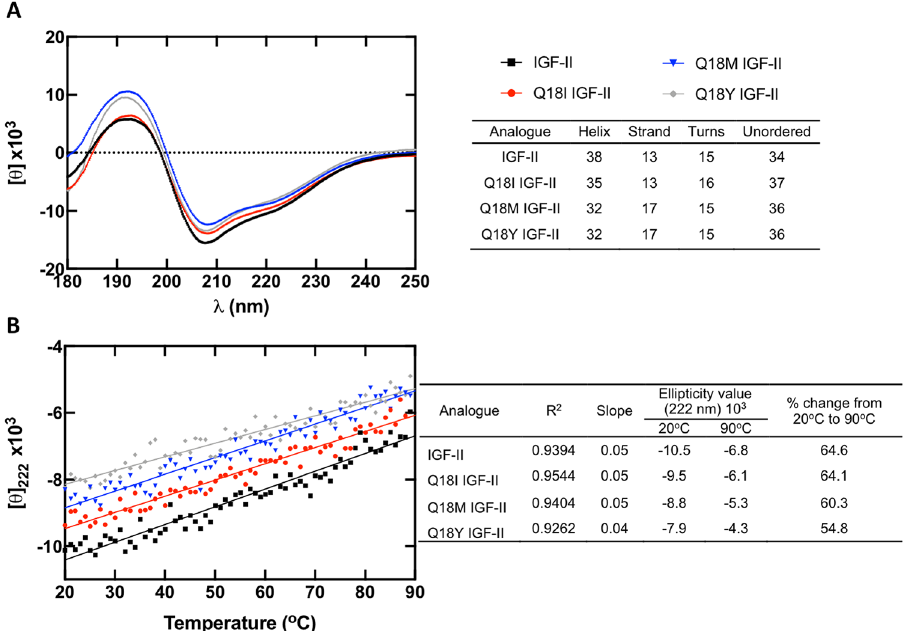
Figure 3. ( A ) CD spectra of IGF-II (black), Q18I IGF-II (red), Q18M IGF-II (blue) and Q18Y IGF-II (grey). Percent helical content shown in the table was calculated using the CDSSTR algorithm for deconvolution against the reference protein database set SMP180. ( B ) Temperature denaturation assays monitored by ellipticity at 222